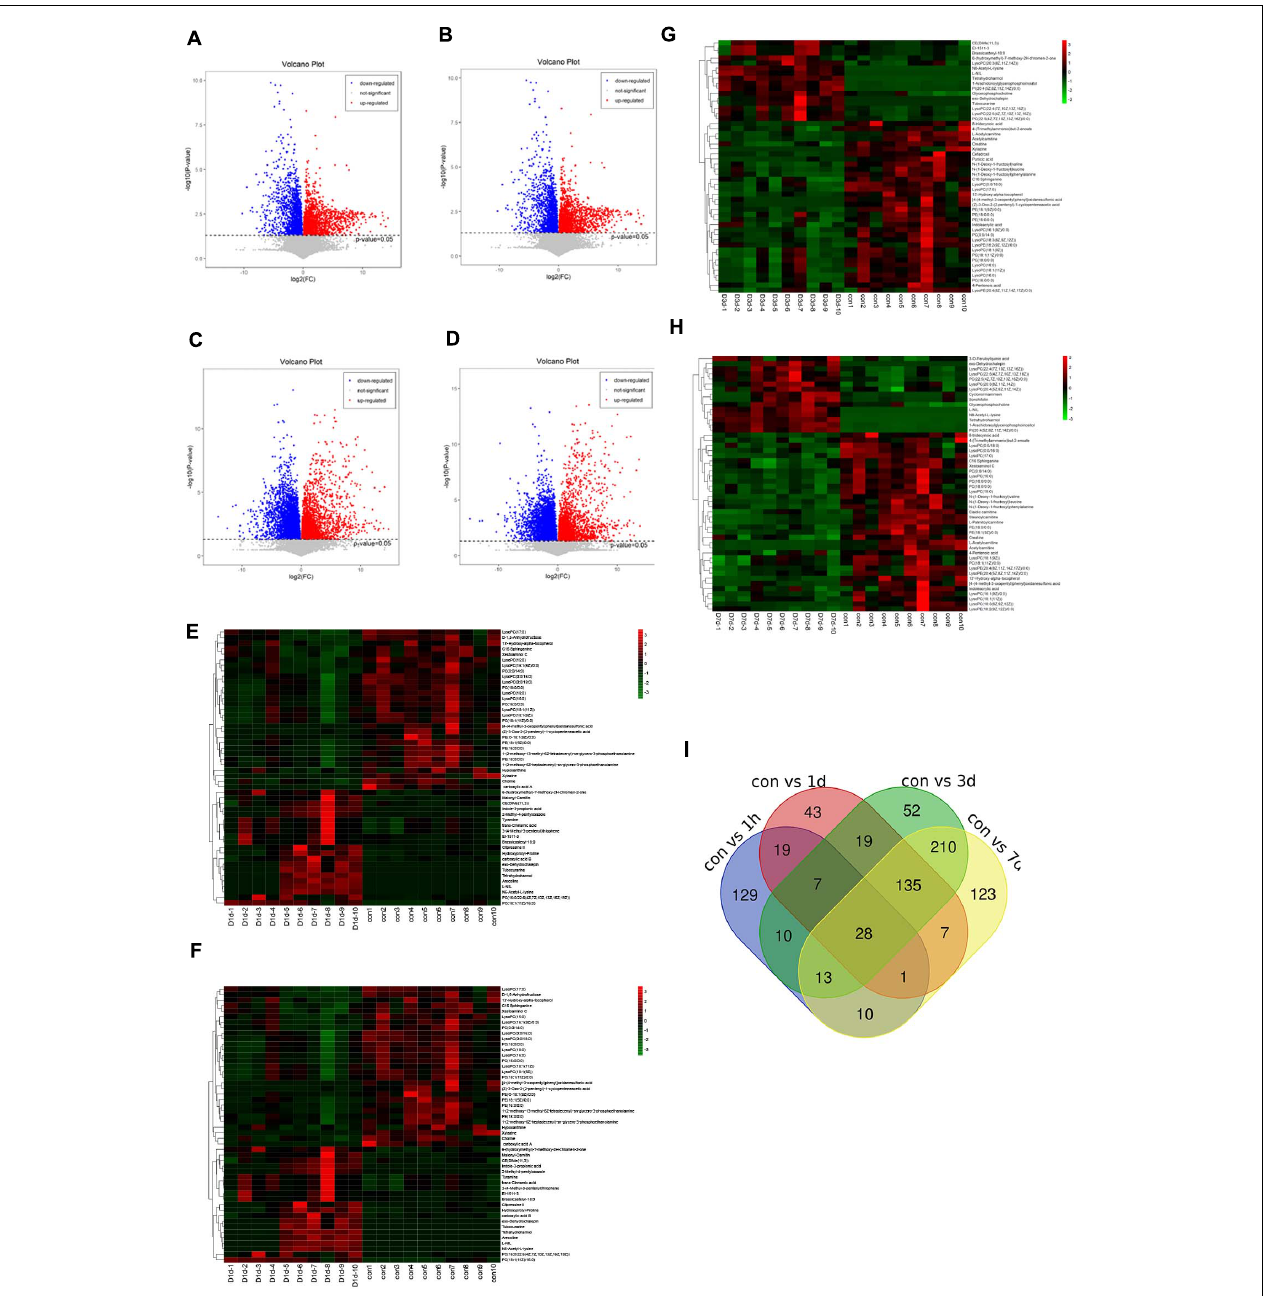
FIGURE 3 | Differential metabolites in serum. Volcano plots show the average normalised quantities of the differentially expressed metabolites in the control and the post-operation groups ( A : con vs. 1 h, B : con vs. 1 day, C : con vs. 3 days, D : con vs. 7 days). Heat maps show the top 50 differential metabolites in the control groups compared with the post-operation groups ( E : con vs. 1 h, F : con vs. 1 day, G : con vs. 3 days, H : con vs. 7 days). Carboxylic acid A : 3,4,5-trihydroxy-6-[4- (4-methyl-3-oxopentyl)phenoxy]oxane-2-carboxylic acid. Carboxylic acid B : 6-{4-[3-(3,7-dimethylocta-2,6-dien-1-yl)-5,7-dihydroxy-6-(4-hydroxy-3-methylbut-2-en- 1-yl)-4-oxo-3,4-dihydro-2H-1-benzopyran-2-yl]-3-hydroxyphenoxy}-3,4,5-trihydroxyoxane-2-carboxylic acid. (I) A Venn diagram was applied to illustrate that differential metabolites were identified by four cross-comparisons of different postoperative groups with the control